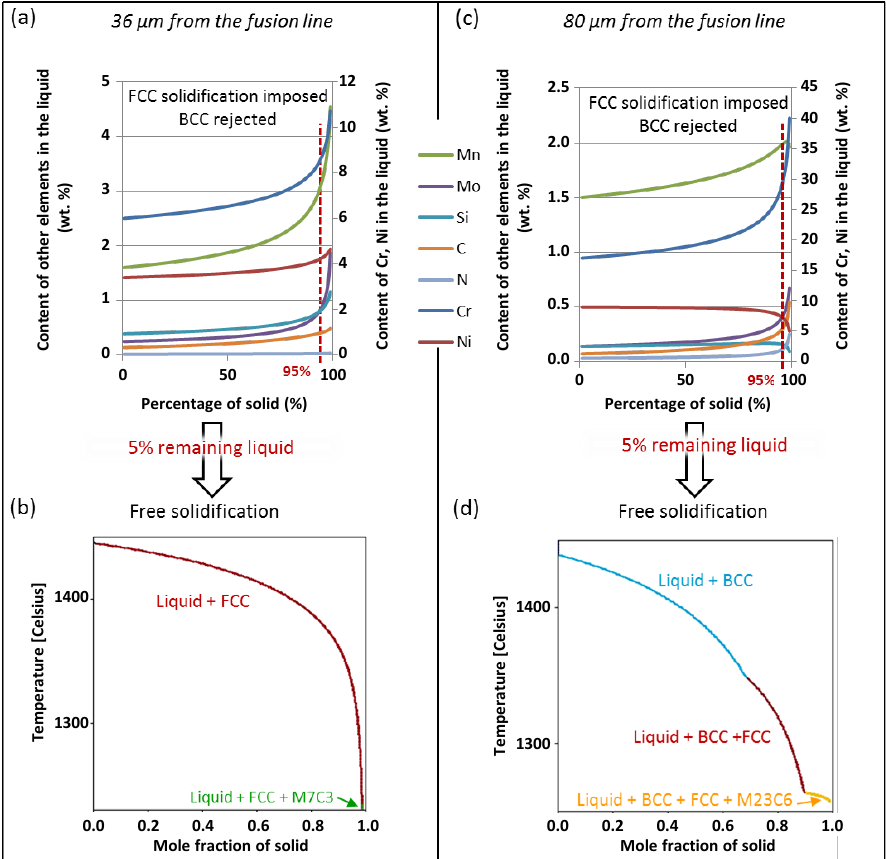
Figure 12. Solidification paths computed with Thermo-Calc ® and the TCFE6 database using a modified Scheil-Gulliver model. ( a ) BCC ferrite rejected for the local compositions at 36 µm from the fusion line (in wt. %): Cr = 6.0, Ni = 3.4, Mn = 1.6, Mo = 0.25, Si = 0.39, C = 0.14, N = 0.016, Fe = bal.; ( b ) Free solidification for the 5% remaining liquid at 36 µm from the fusion line; ( c ) BCC rejected for the local compositions at 80 µm from the fusion line: Cr = 17.0, Ni = 9.0, Mn = 1.5, Mo = 0.14, Si = 0.14, C = 0.07, N = 0.03, Fe = bal.; ( d ) Free solidification for the 5% remaining liquid at 80 µm.